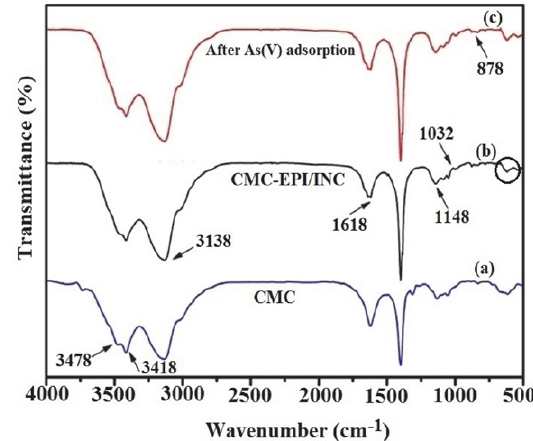
Fig. 1. FT-IR spectra of a) CMC b) CMC-EPI/INC before and C) after As(V)